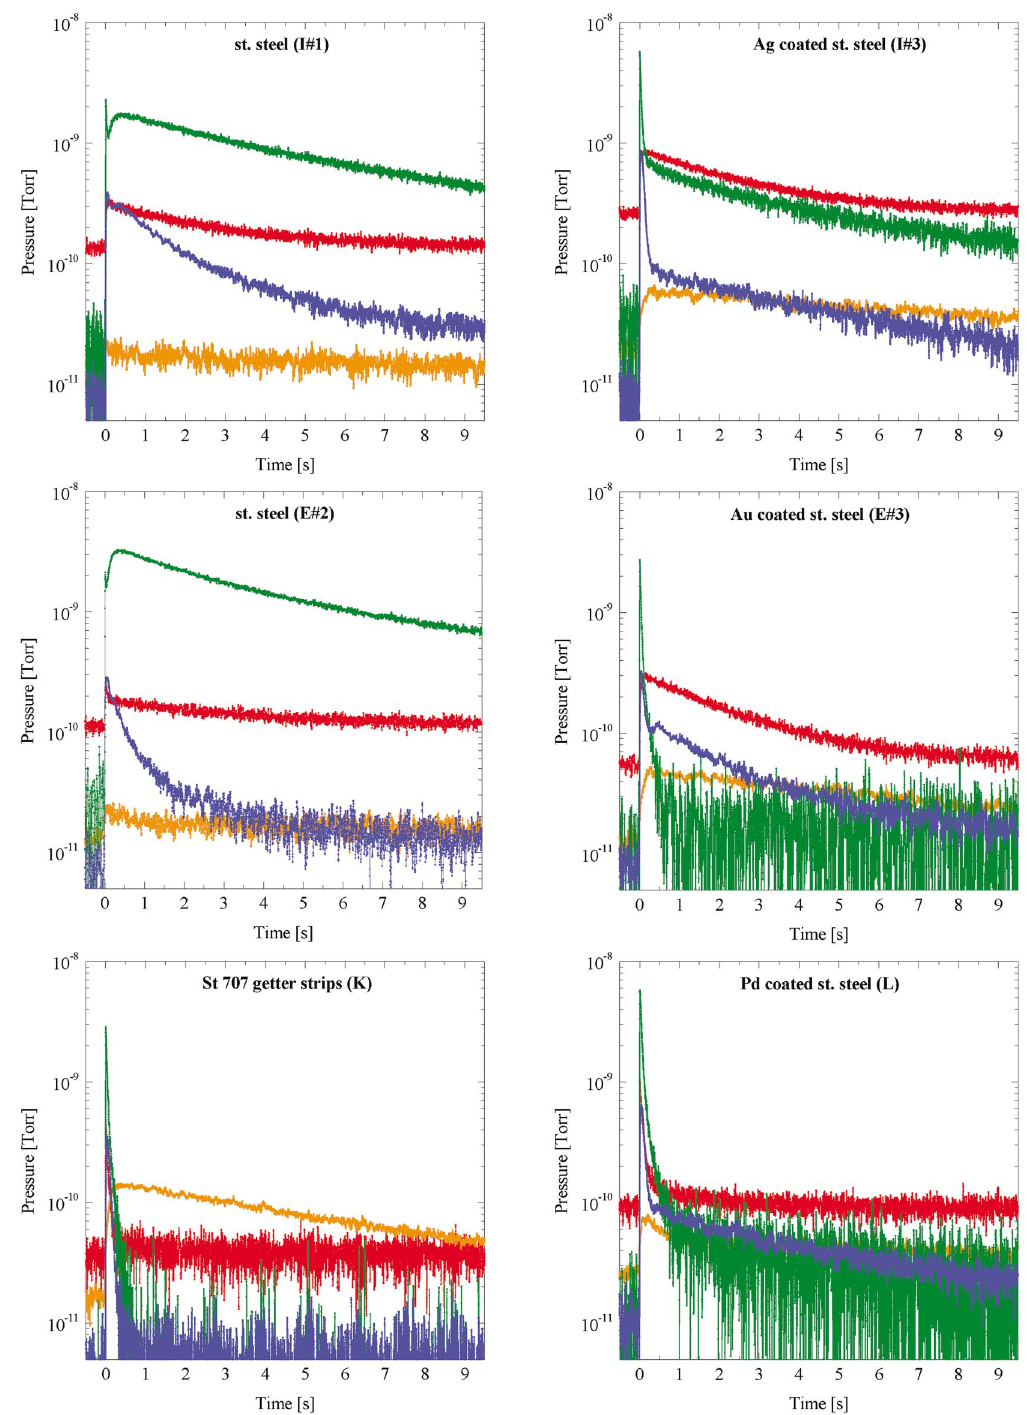
FIG. 3. (Color) Single shot partial pressure rises of H vacuum chambers using pulses of 1 : 5 (cid:1) 10 9 Pb 53 (cid:2) ions impacting under 89 : 2 (cid:7) grazing